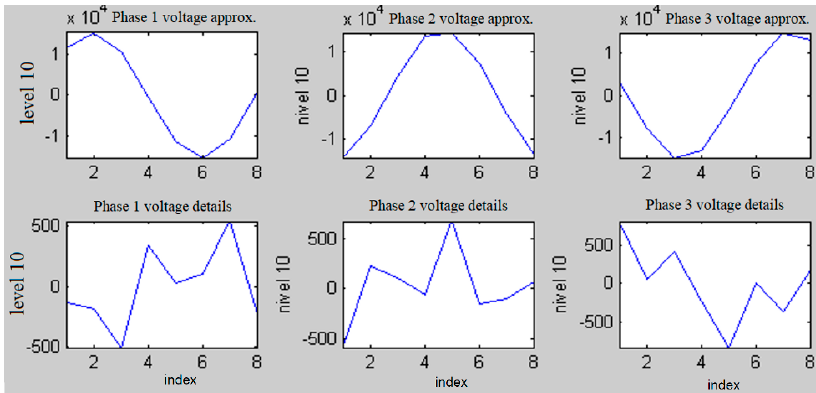
Figure 11. Vectors of details for voltages, levels 7–9, first case study.